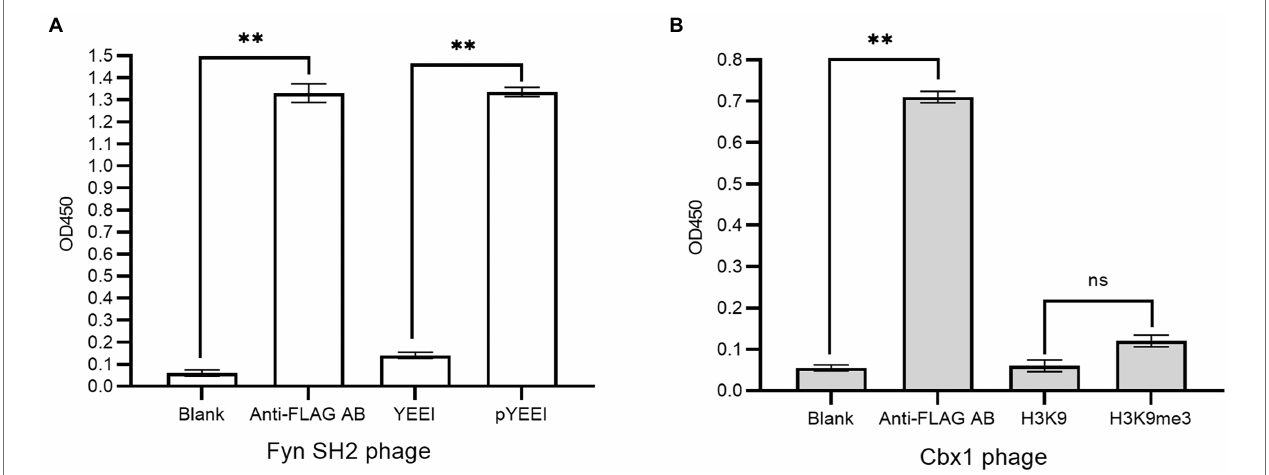
FIGURE 1 | Supernatant phage ELISA showed the expression level and binding to the pY (MidT-pY324) peptide of the Fyn SH2 domain (A) and the H3K9me3 peptide of Cbx1 (B) , respectively. ELISA signals (OD450) are plotted as a function of the supernatant phages added to the streptavidin-coated wells conjugated with biotinylated modified peptides (pY or H3K9me3), unmodified counterparts (Y or H3K9) as negative controls and skim milk as the blank control, respectively. The anti-FLAG antibody (AB)-coated wells were taken as positive controls. The experiments were repeated three times and a statistical significance in comparison was